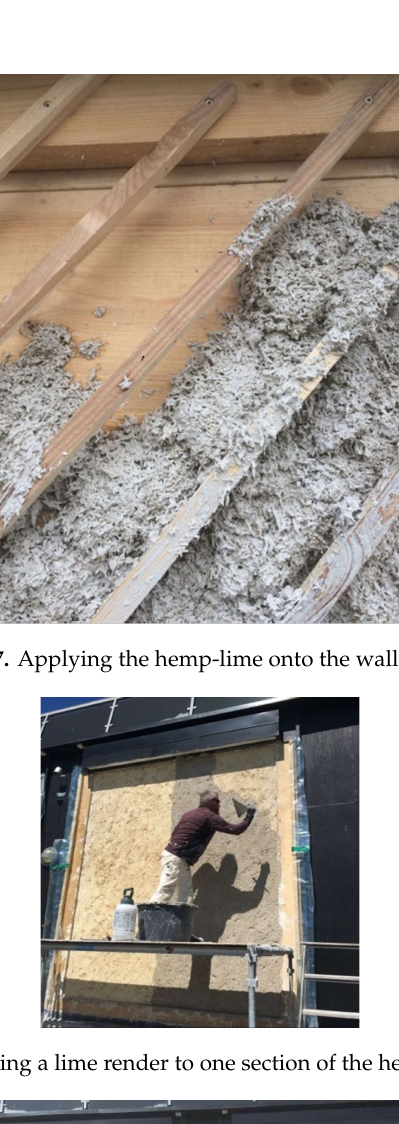
Figure 6. Wooden slats are placed diagonally on the timber for carrying the render.